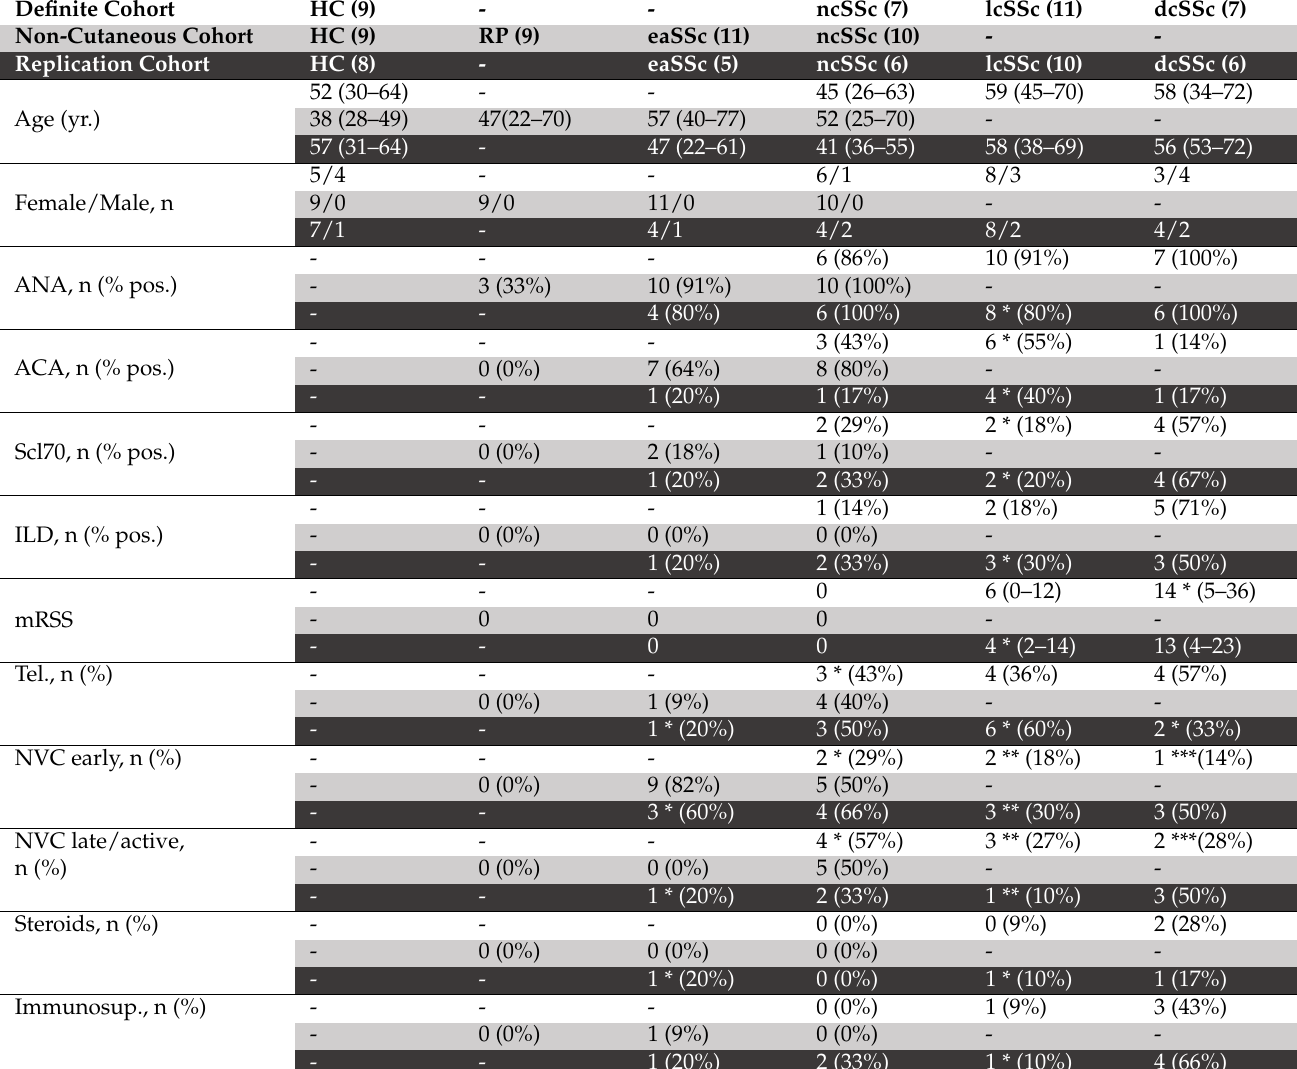
Table 1. Demographics and clinical features of subjects enrolled in the study. Values reported indicate the number (n) of patients and the median for each parameter (Interquartile Range (IQR), if not otherwise indicated). ACA, anticentromere antibodies; ANA, antinuclear antibodies; dcSSc, diffuse cutaneous SSc; eaSSc, early SSc; HC, healthy controls; ILD, Interstitial Lung Disease; Immunosupp., immunosuppressive therapy; lcSSc, limited cutaneous SSc; mRSS, modified Rodnan Skin Score; ncSSc, non-cutaneous SSc; NVC, nailfold videocapillaroscopy; pos, positivity; RP, Raynaud’s Phenomenon; Scl70, anti-topoisomerase antibodies; Tel., telangiectasia; yr., years. * = 1 patient unknown, ** = 6 patients unknown, *** = 3 patients